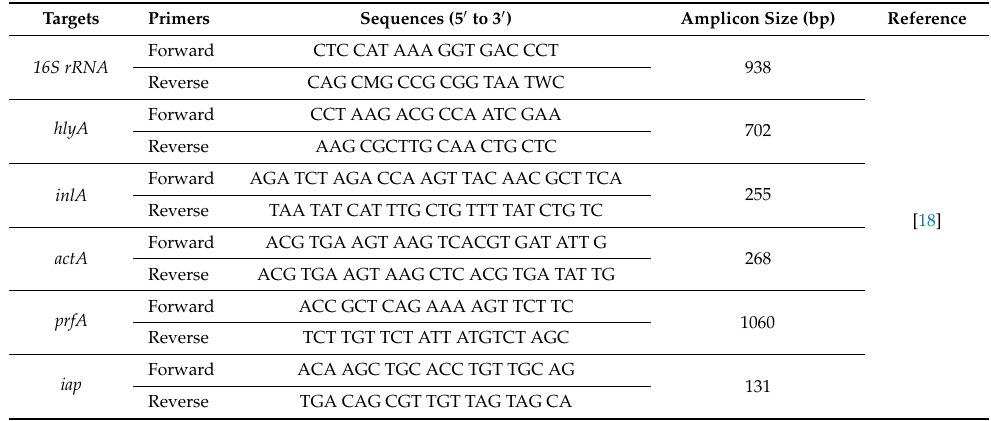
Table 1. List of PCR primers used in the molecular detection and characterization of L. monocytogenes . Targets Primers Sequences (5 (cid:48) to 3 (cid:48) ) Amplicon Size (bp)